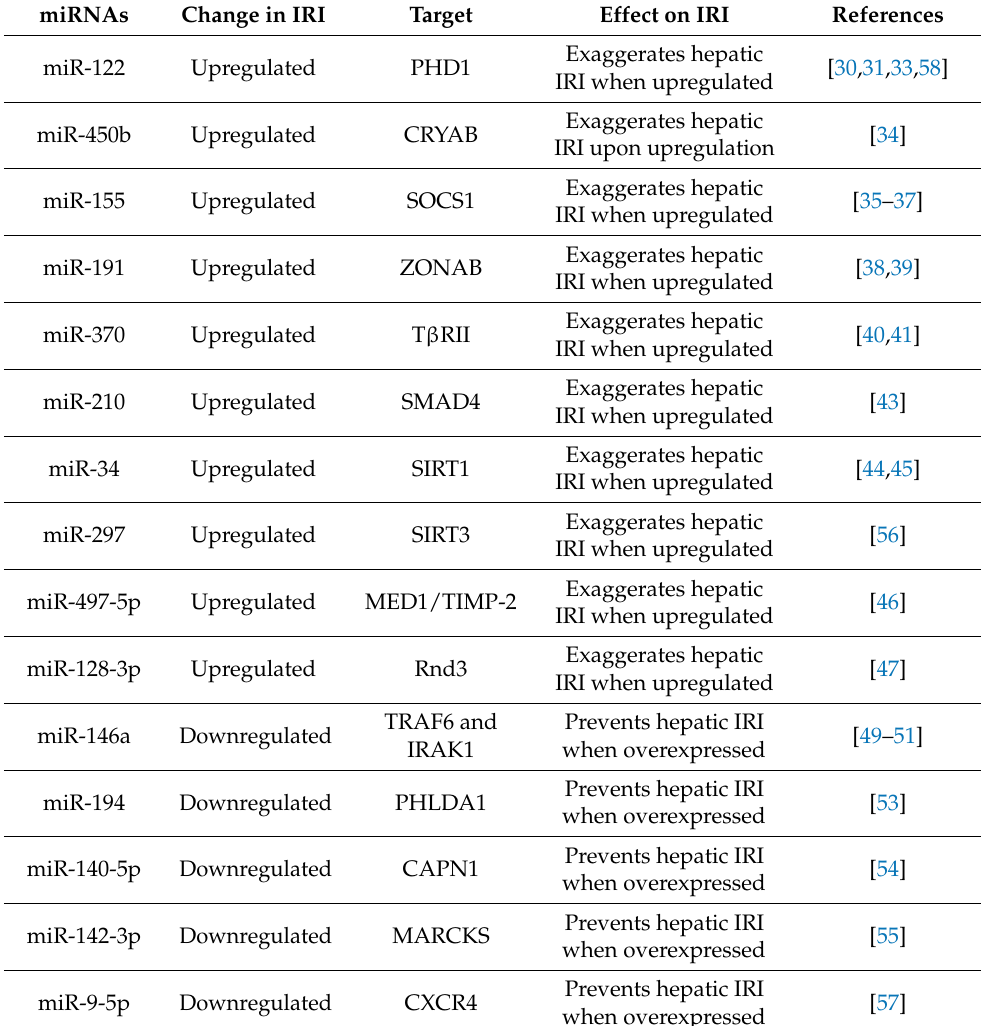
Table 1. miRNAs and their function in hepatic